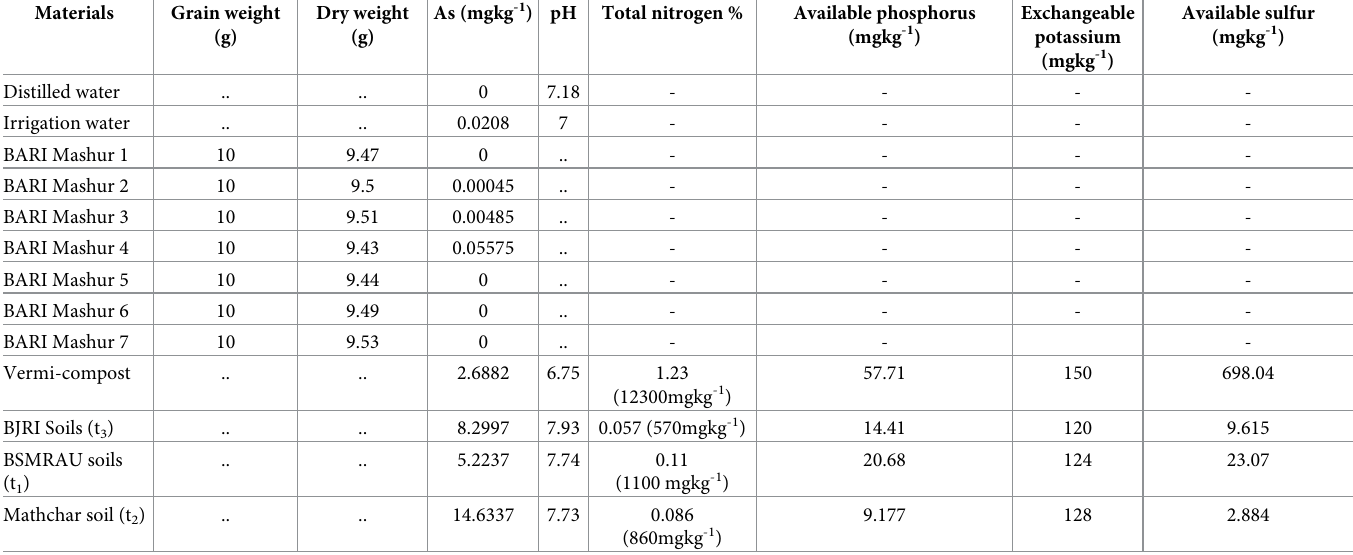
Exchangeable Available sulfur (mgkg -1 ) potassium (mgkg -1 ) (mgkg -1 )